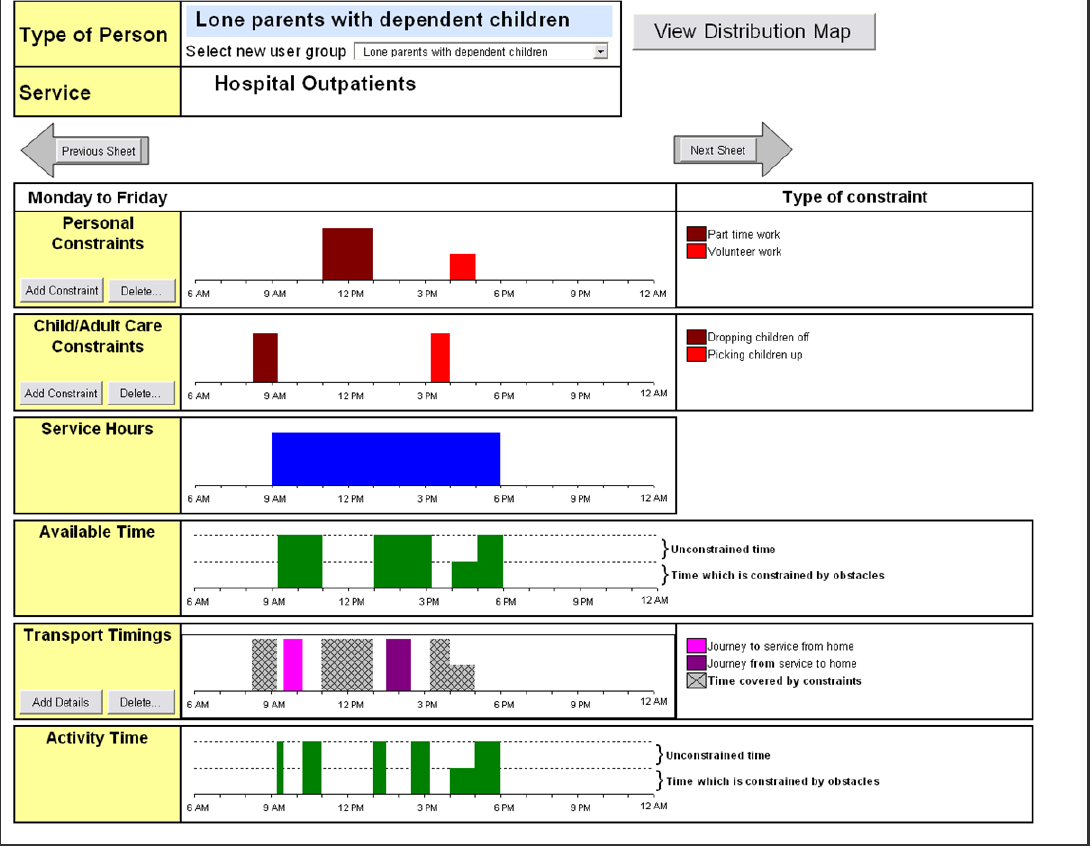
Figure 8. Typical user constraints sheet for a lone parent Source: Jones and Paskins (2008), Figure